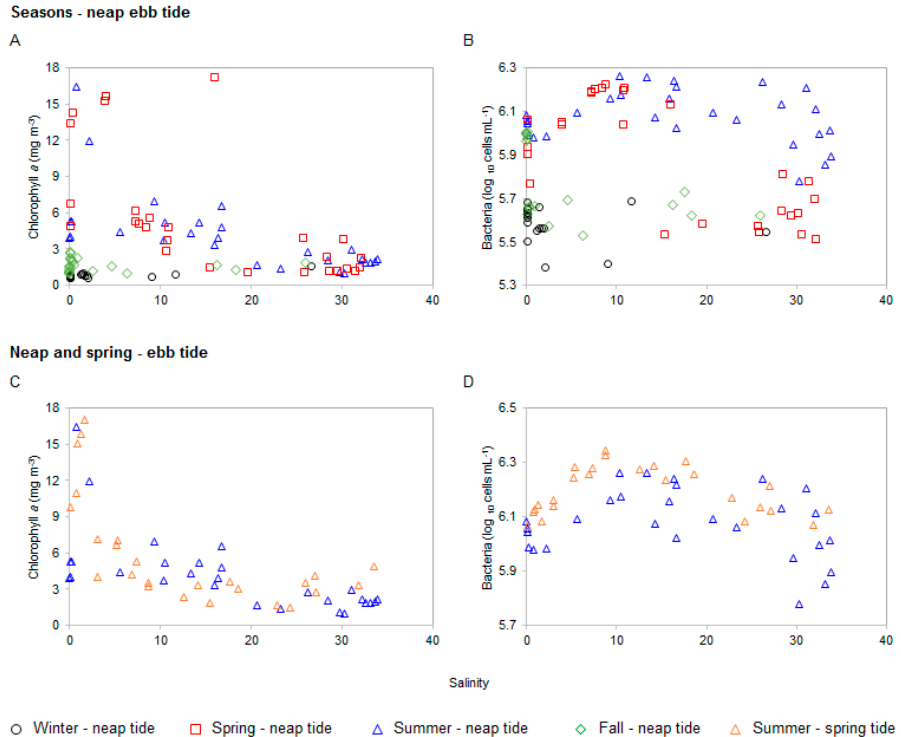
Figure 4. Relationship between chlorophyll a , and bacteria versus the conservative tracer salinity for seasonal neap tides ( A , B ), and a summer neap and spring tides ( C , D ) in the Lima estuary.